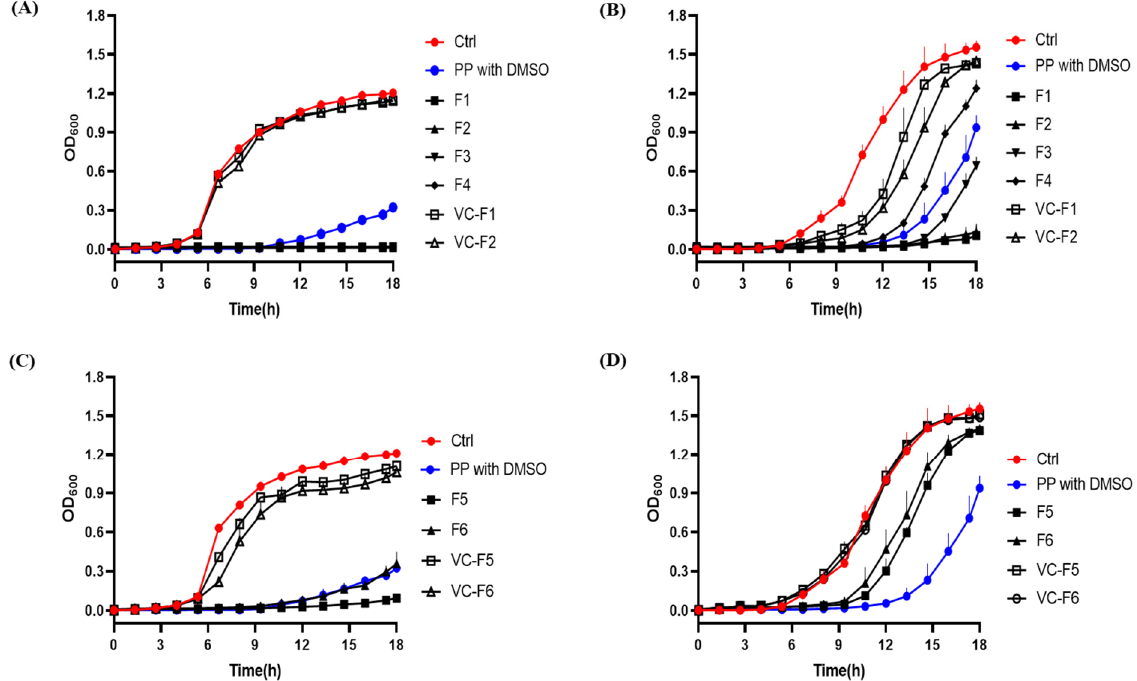
Figure 6. Time-kill kinetics of S. aureus ( A , C ), C. albicans ( B , D ) incubated with various formulations. VC-F1, VC-F2, VC-5, and VC-6 represent vehicle controls of F1, F2, F5, and F6 without propolis. Data are expressed as mean ± S.D. ( n = 3).